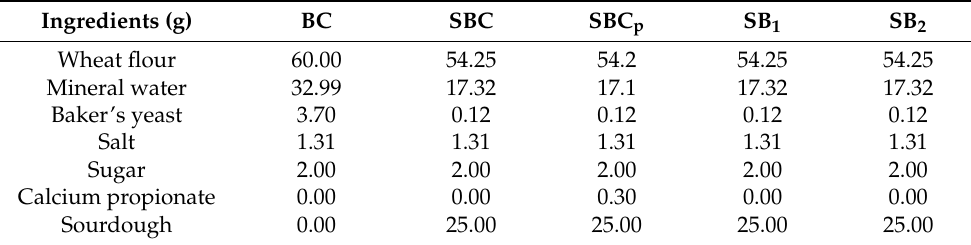
Table 2. Formulation of breads in g of ingredient per 100 g of